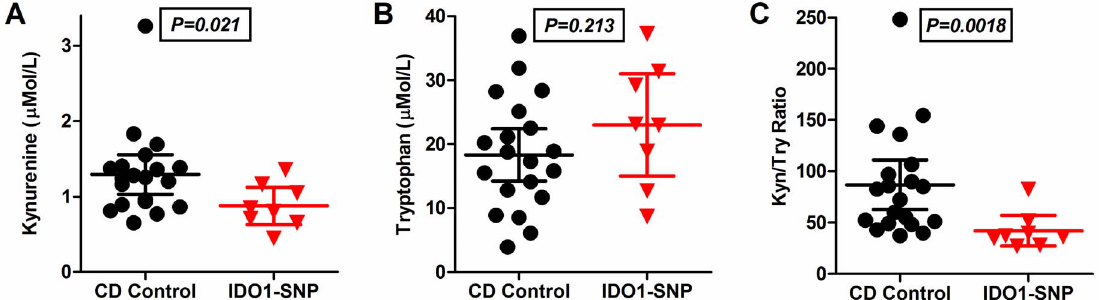
Fig. 1. IDO1 activity measurement in Crohn’s disease patients with moderate-severely active disease. HPLC was used to measure serum A) Kynurenine and B) Tryptophan from Crohn’s disease patients with moderate or severely active Crohn’s disease. Controls, CD patients who did not carry SNPs of IDO1 (n 5 20), were compared to CD patients who did carry IDO1 SNPs (n 5 8). C) The Kyn/Trp ratio, a surrogate of IDO1 activity, was significantly lower in the patients with IDO1